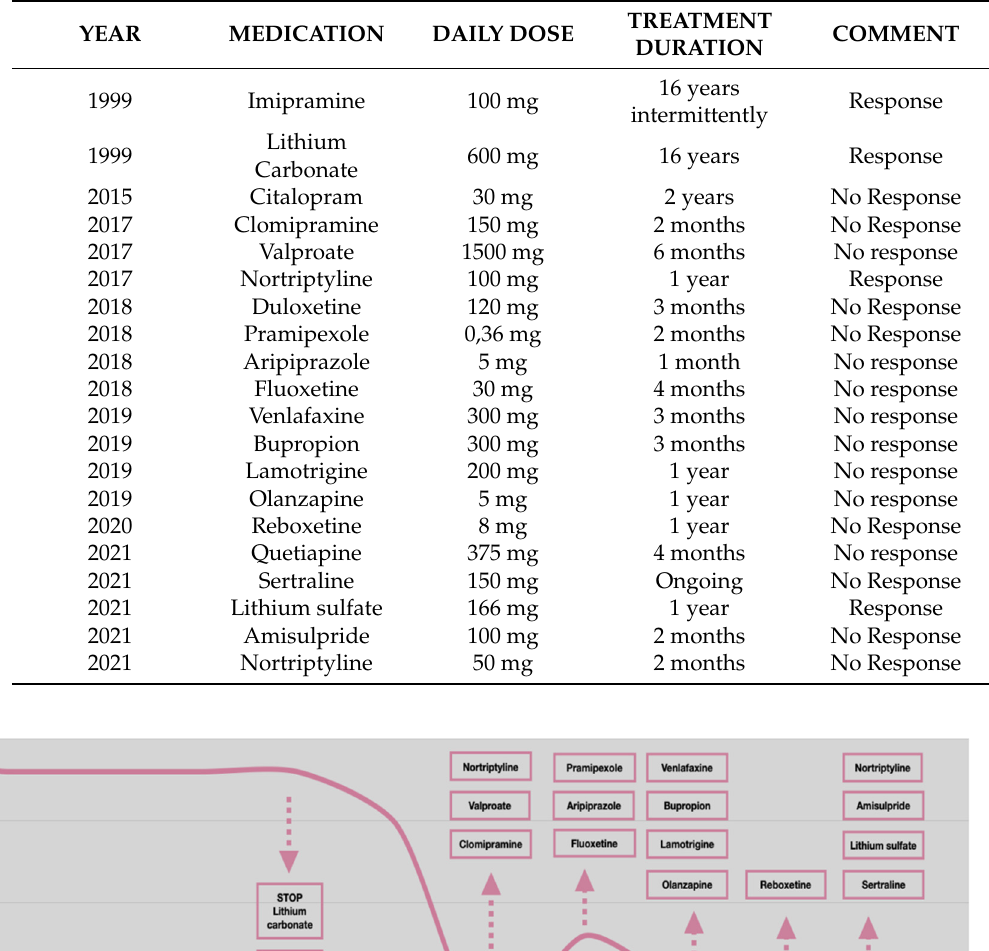
Table 5. Treatment history.